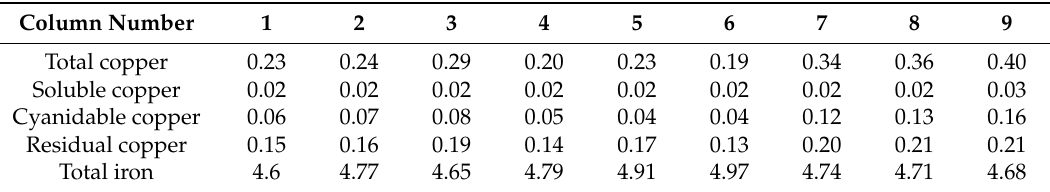
Table 6. Chemical analysis of the residual ore in each